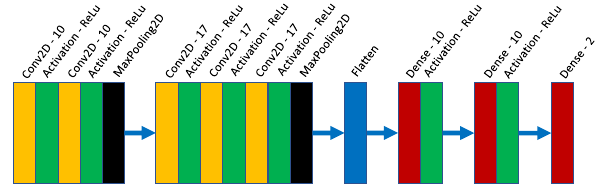
Fig. 2 Schematic view of the network architecture that has been adopted. The numbers next to “Conv 2D” and to “Dense” represent respectively the number of filters and the number of neurons of that layer